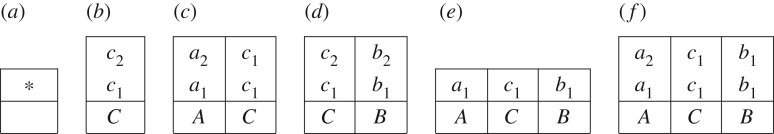
Relational tables for a presheaf (a–e) and its nearest sheaf (a–d,f).